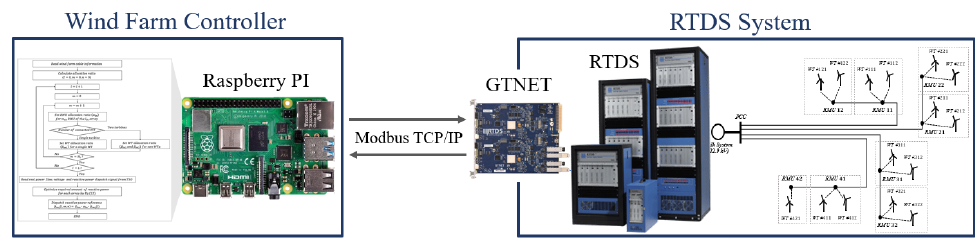
Figure 6. Simulation Configuration with RTDS and Raspberry PI. Table 2. Case study